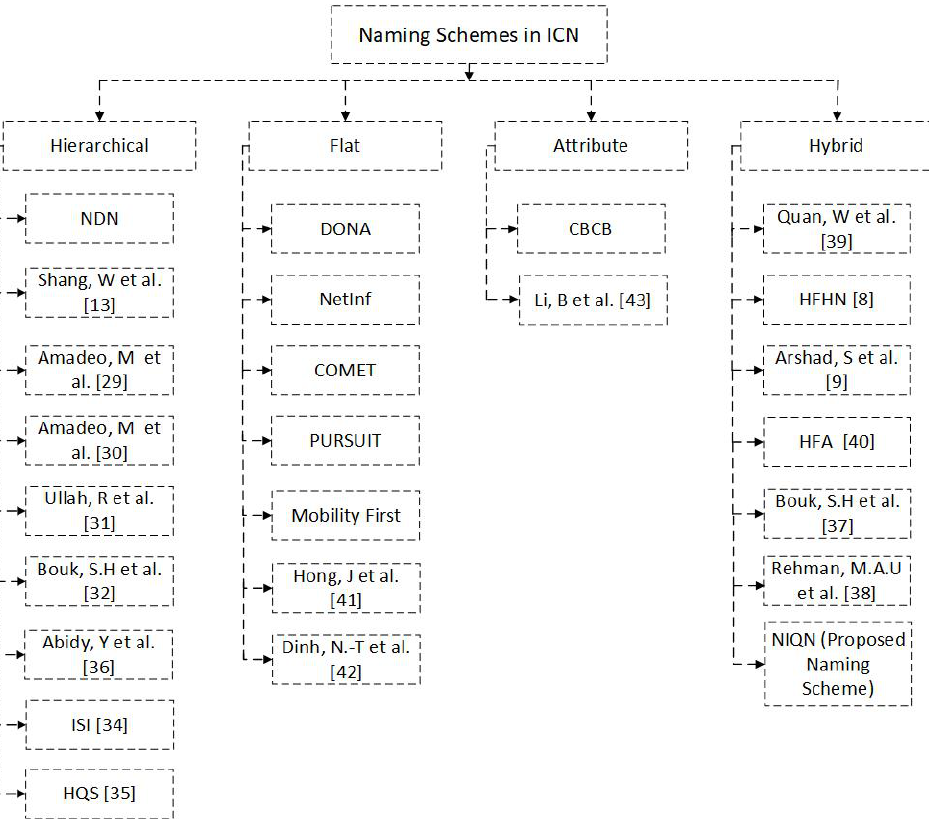
Figure 2. Naming Schemes in